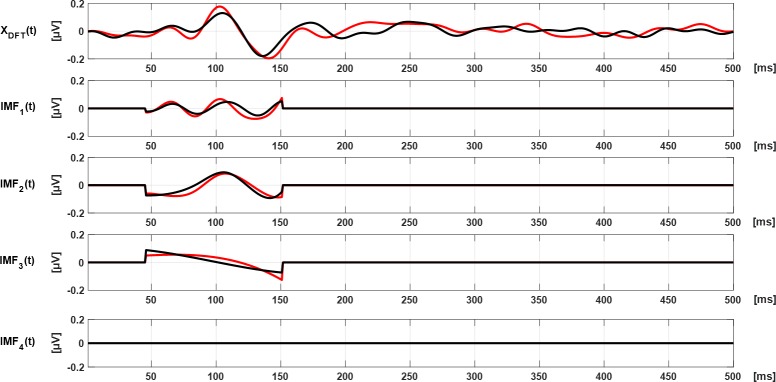
Original signal and IMF1–IMF4 from the OD (black) and OS (red) from a control subject.